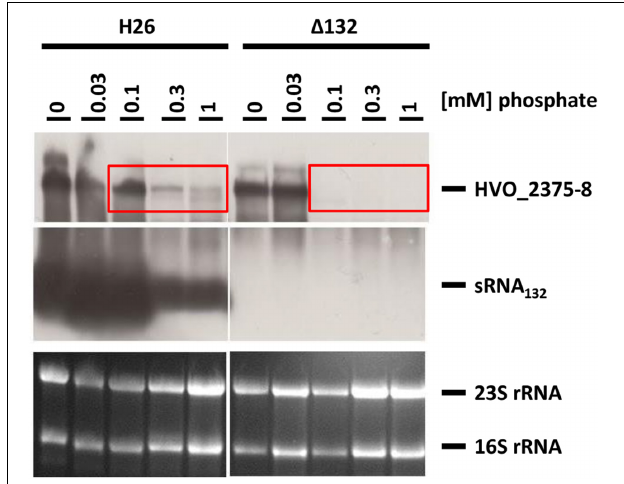
FIGURE 6 | Kinetic analysis of the HVO_ 2375-2378 operon mRNA level after the onset of phosphate starvation. (A) The operon encodes a phosphate-specific ABC transporter. The wild-type (wt) H26 and the sRNA132 gene deletion mutant ( (cid:49) ) were grown to mid-exponential growth phase in the presence of phosphate (1 mM). The cells were harvested and resuspended in phosphate-free medium. At the time points indicated at the top aliquots were removed, RNA was isolated and used for Northern blot analysis with an operon-specific and a sRNA-specific probe. Ethidium bromide stained 23S and 16S rRNAs are shown at the bottom. (B) The signals of the Northern blots were quantified densitometrically, and the kinetic changes of relative transcript levels are